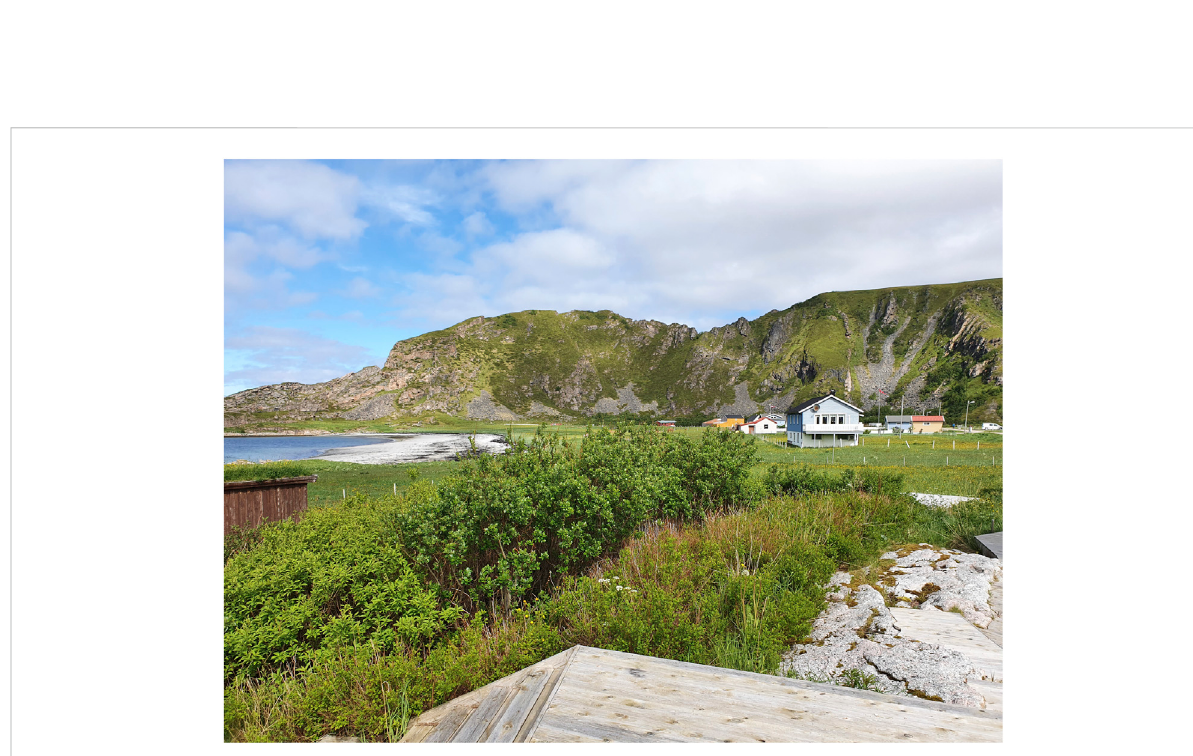
FIGURE 6 The settingofthesettlement moundSjåberget,Andøya,with thebeachto thenorth.A similar beachissituated justsouthofthemound. Photo: Vibeke Vandrup Martens, NIKU